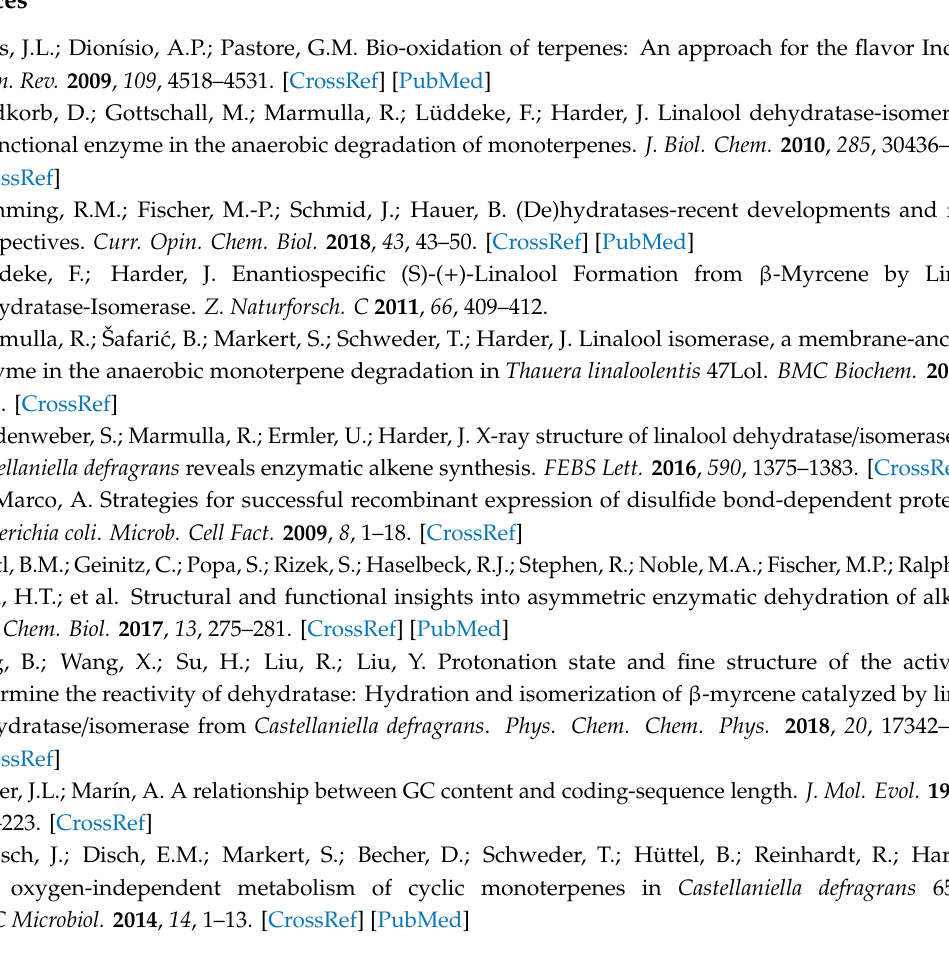
deg cm 2 dmol − 1 ; Table S1: Codon-optimized DNA sequence for expression of C-terminally His 10 -tagged Ldi in E. coli ; Table S2: Codon-optimized DNA sequence for expression of C-terminally His 10 -tagged OmpA-Ldi in E. coli ; Table S3: Codon-optimized DNA sequence for expression of N-terminally His 10 -tagged nosig-Ldi in E. coli ; Table S4: Codon-optimized DNA sequence for expression of C-terminally His 10 -tagged nosig-Ldi in E. coli ; Table S5: Primers used for amplification of Ldi constructs for cloning into pET26b( + ) vector. Underlined nucleotides are marking restriction sites; Table S6: Primers used for site-directed mutagenesis of Ldi cysteine residues; Table S7: E. coli strains tested for expression of